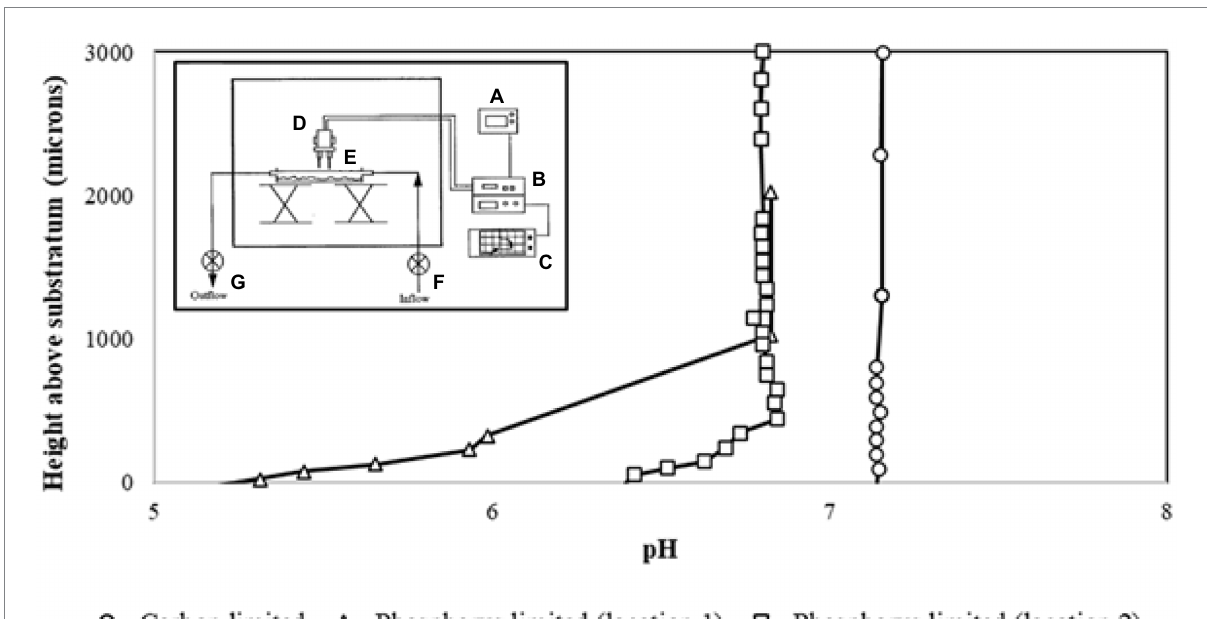
FIGURE 4 The specimen pH profile of Citrobacter biofilm. The circle denotes the specimen pH profile of a Citrobacter biofilm pre-grown and measured under carbon limitation; measurements were recorded under laminar flow (9.5 ml/min). The electrode penetrated through the biofilm to the substratum. The square and triangle denote the specimen pH profiles of two locations measured in a Citrobacter biofilm pre-grown under carbon limitation and then imaged with a phosphorus limiting medium; laminar flow conditions were the same. The profiles suggest that the diffusion boundary layer is approximately 400 mm in depth. The inset illustrates the overview of the pH microelectrode measurement set-up; (A) power supply, (B) preamplifier, (C) chart recorder, (D) measurement electrode and reference electrode, (E) glass culture flow cell, (F) culture inflow, (G) culture outflow. Data digitized and replotted from Allan et al.